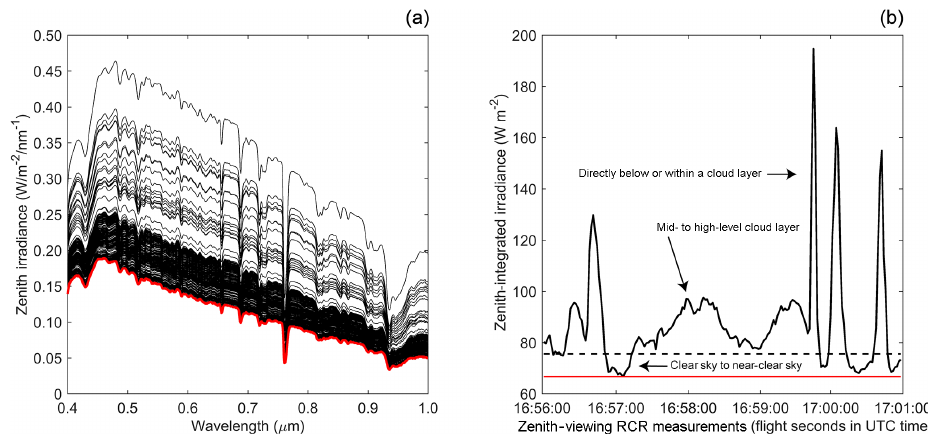
Figure 7. Example zenith remote cosine receptor irradiance measurements for a 29 July flight segment. Panel (a) shows zenith irradiance measurements from 0.4 to 1.0µm. The black lines indicate variability in instantaneous in-flight irradiance for a 5min flight segment. The thick red line signifies the baseline minimum irradiance received, a condition that represents diffuse clear sky to near-clear sky as verified with Fig. 6 results. Panel (b) shows zenith-integrated irradiance (i.e., sum function) from 0.4 to 1.0µm for the same 5min flight segment. The thick black line indicates temporal variance in zenith-integrated irradiance, a measure of sky conditions above the UC-12B aircraft. The dotted line signifies the computed mode (most frequently occurring condition) of zenith-integrated irradiance, an indicator of sky condition stability. The red line serves as the minimum zenith-integrated irradiance baseline. Using the temporal variance in zenith-integrated irradiance, the mode value, and the minimum value, variable sky conditions during flight can be classified and the nadir-viewing spectrometer measurements can be filtered for cloud